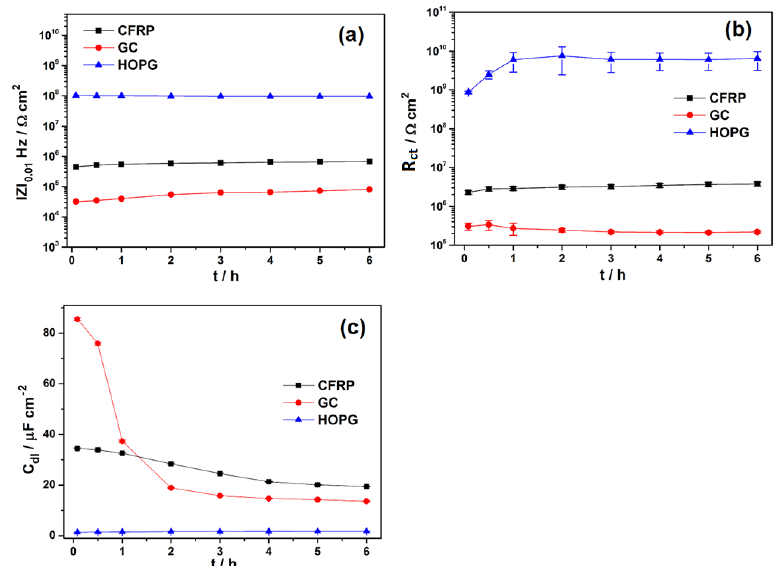
Figure 6. Comparison of the time evolution of measured and fitted parameters from EIS data from CFRP, HOPG, and glassy carbon in 50 mM NaCl adjusted to pH 7, ( a ) low-frequency impedance at 0.01 Hz (IZI 0.01 Hz ), ( b ) charge transfer resistance (Rct), and ( c ) interface capacitance (C dl ) (error bars indicate fitting errors).